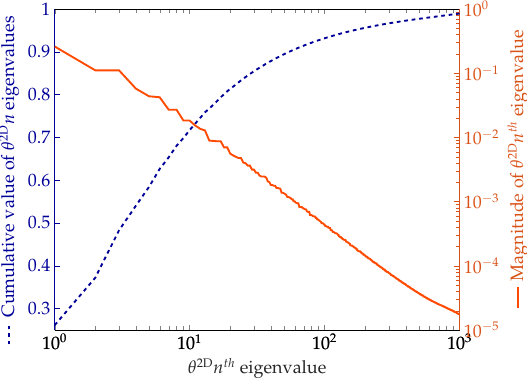
Figure 12. Magnitude of the eigenvalues and their cumulative sum for model problem